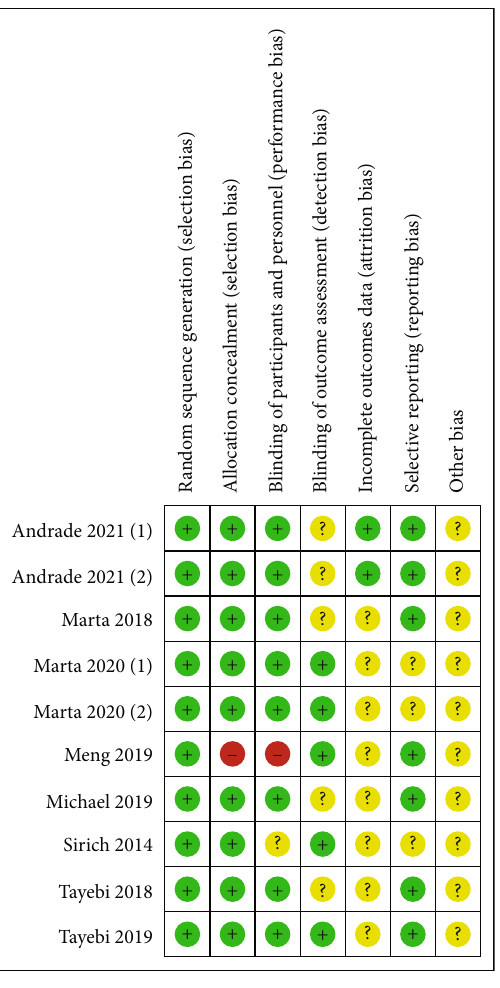
Figure 2: Quality evaluation of included studies and risk of bias (Table 2). Using the random-e ff ects model, fi ve trials were insu ffi cient to detect publication bias.